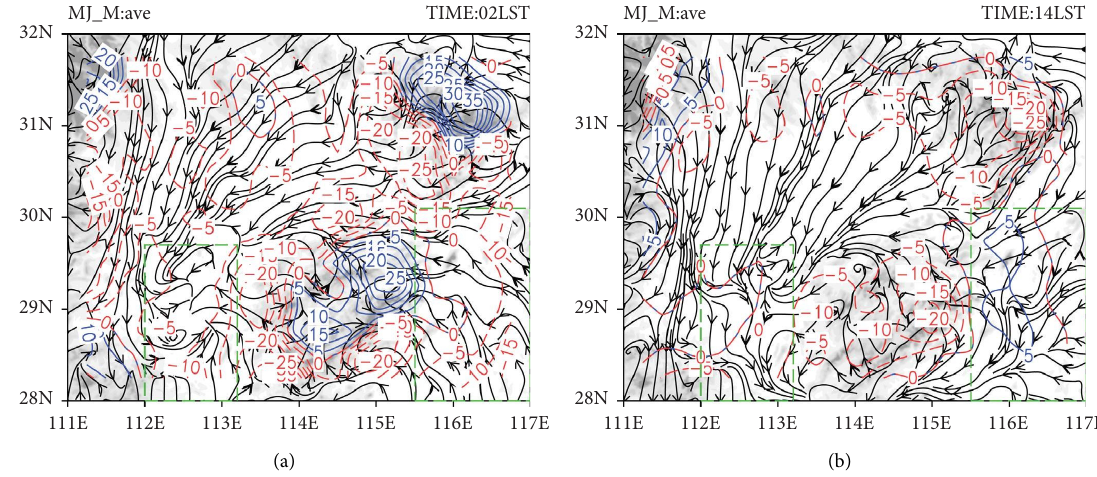
Figure 8: Te same as Figure 7 but at 02:00 (a) and 14:00 (b) on the HHR days in